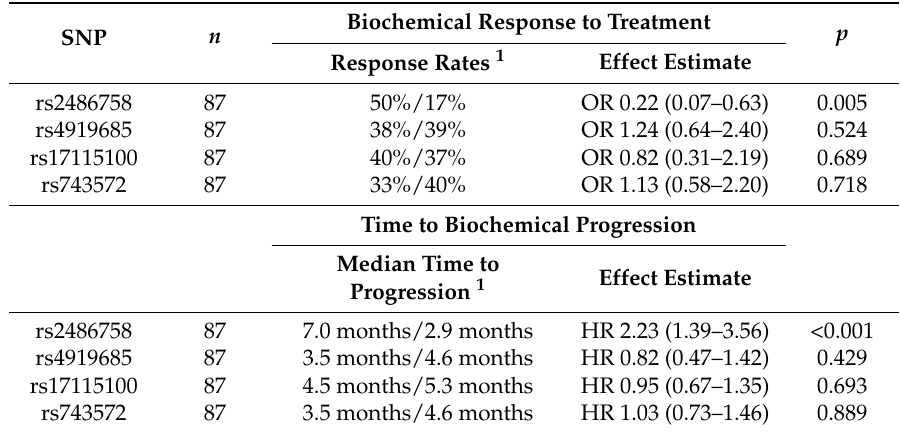
Table 2. Association between common genetic variations in CYP17A1 and biochemical response to abiraterone acetate and prednisone in 87 patients with metastatic castration-resistant prostate cancer. SNP